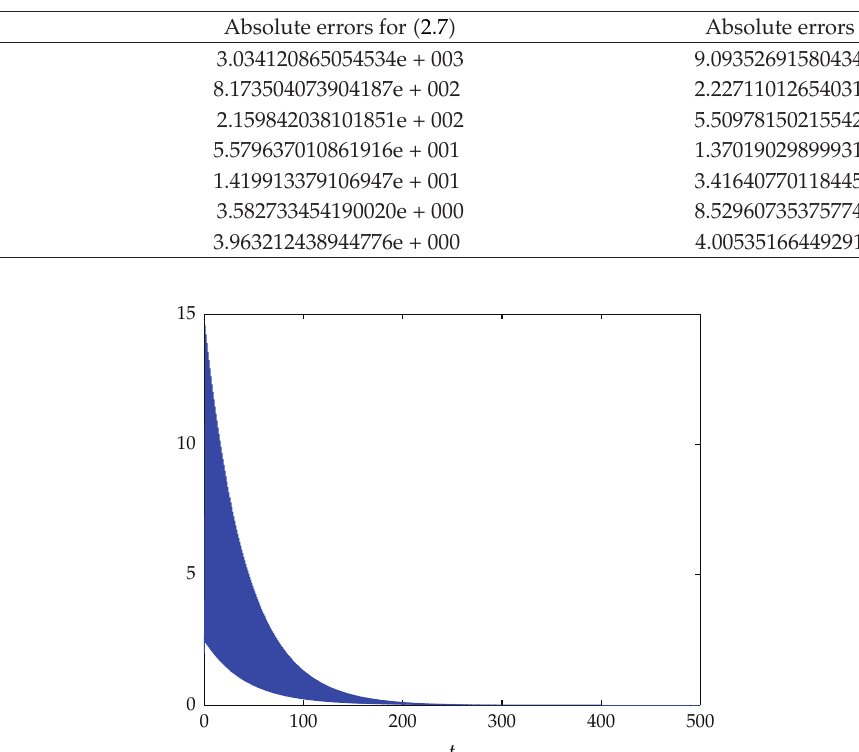
Figure 2: The numerical solution obtained by (cid:6) 4.13 (cid:7) in case of the 2-step BDF method to (cid:6) 4.6 (cid:7) .